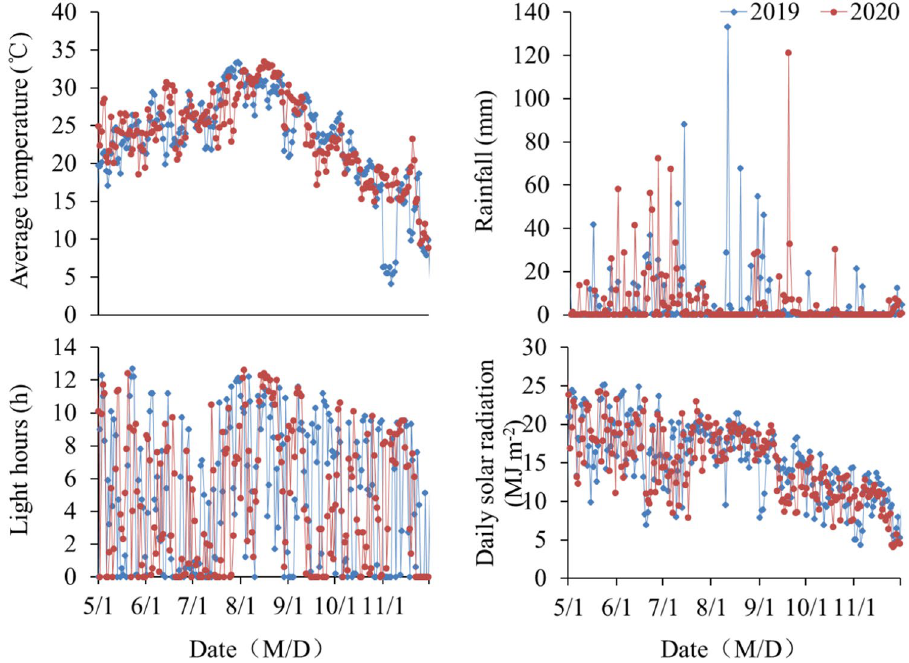
Figure 6. Changes in the climate resources from 2019 to 2020. This figure was created using Microsoft Excel